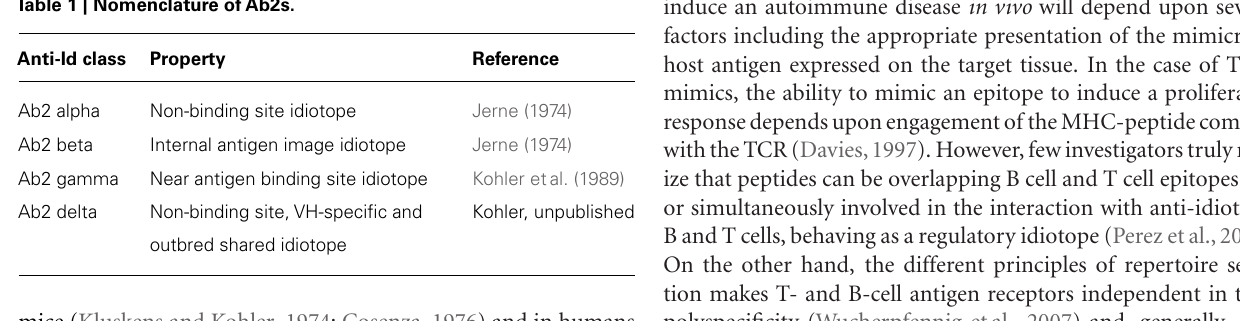
Table 1 | Nomenclature